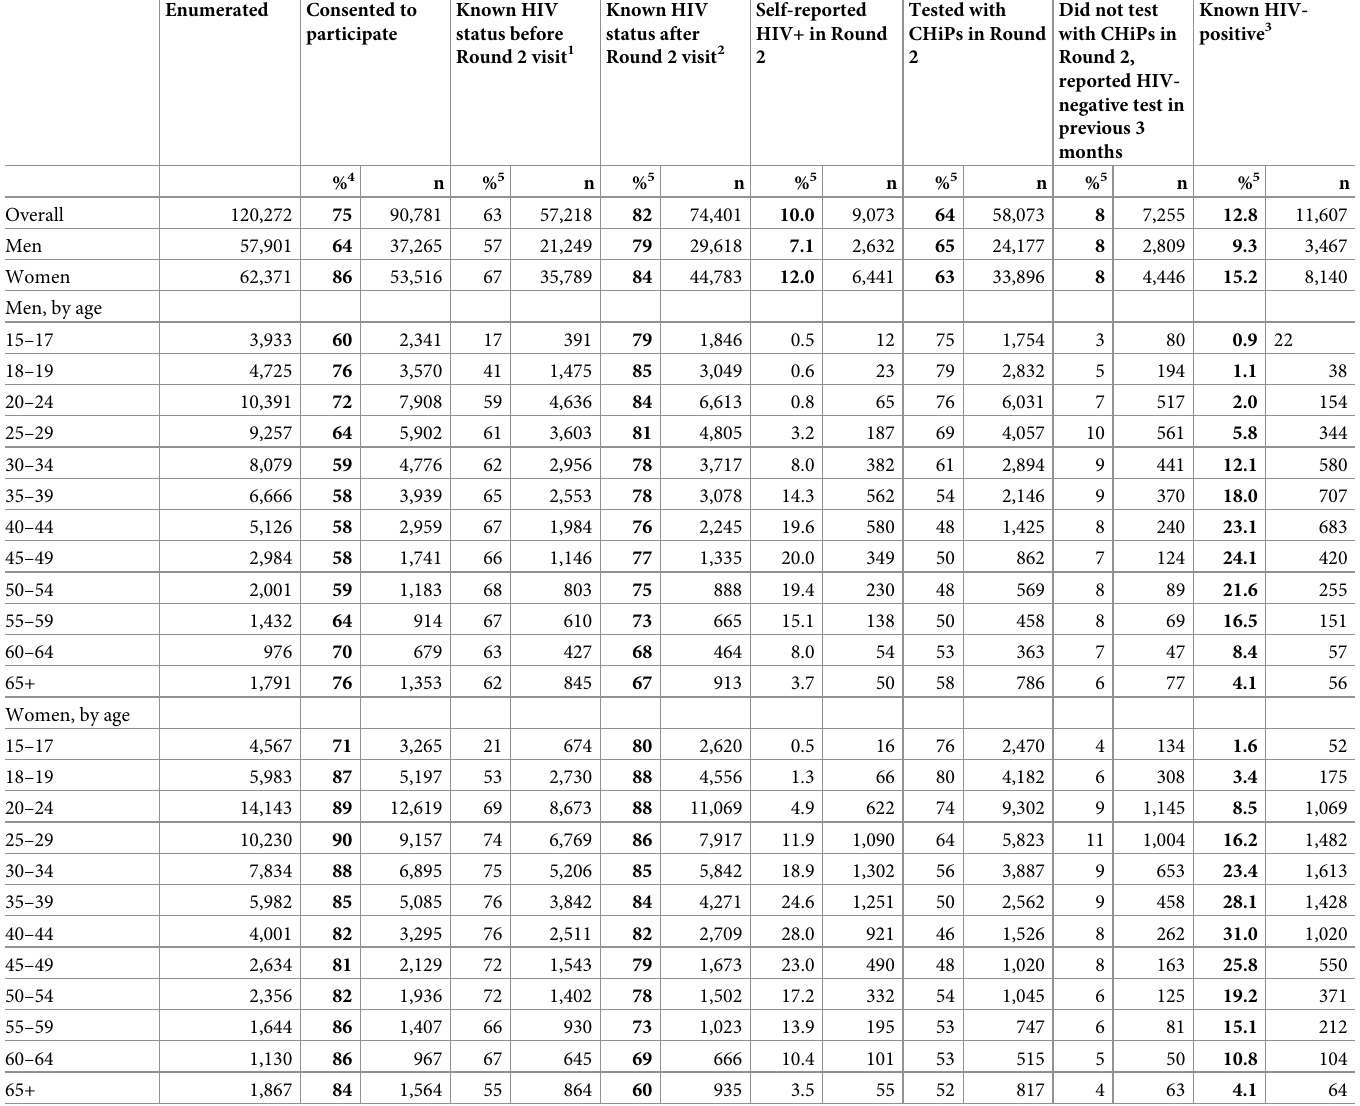
Table 1. Cascade from enumeration, through participation and knowledge of HIV status, in Round